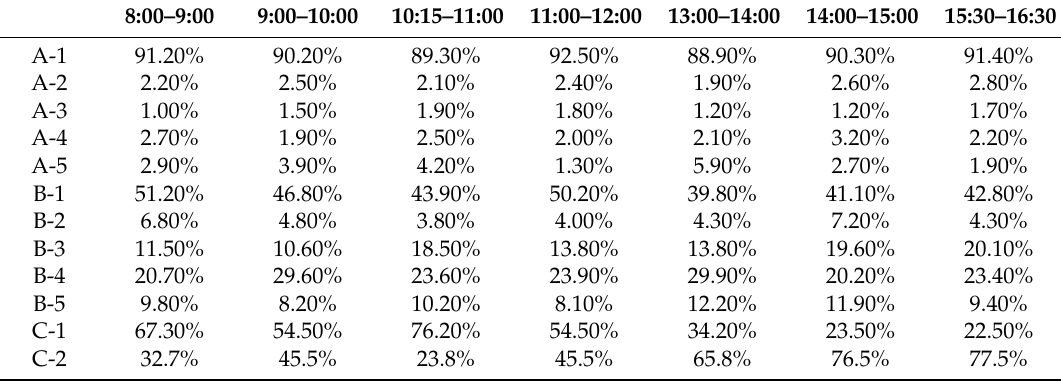
Table 5. Percentage of time spent on different tasks in DWT, IWT, and